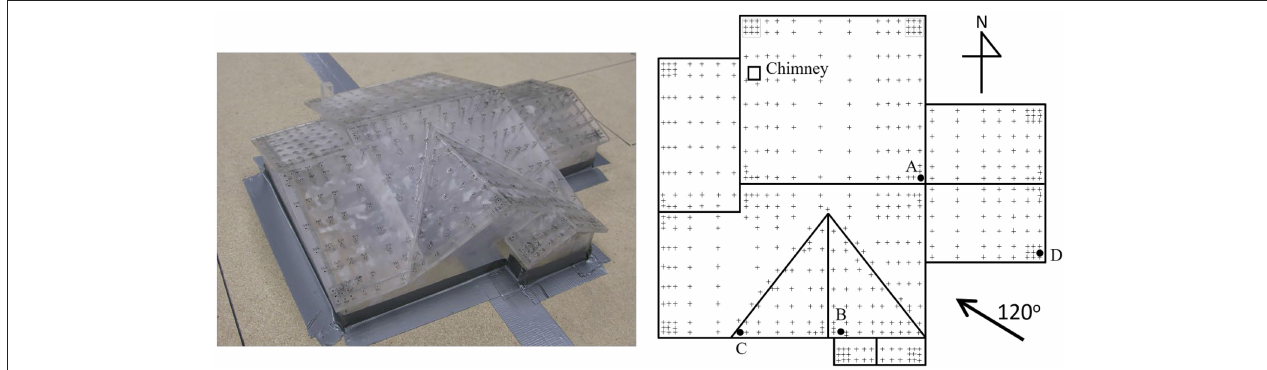
FIGURE 1 | Model, tap layout and wind direction (wind direction of 0 deg is from the north